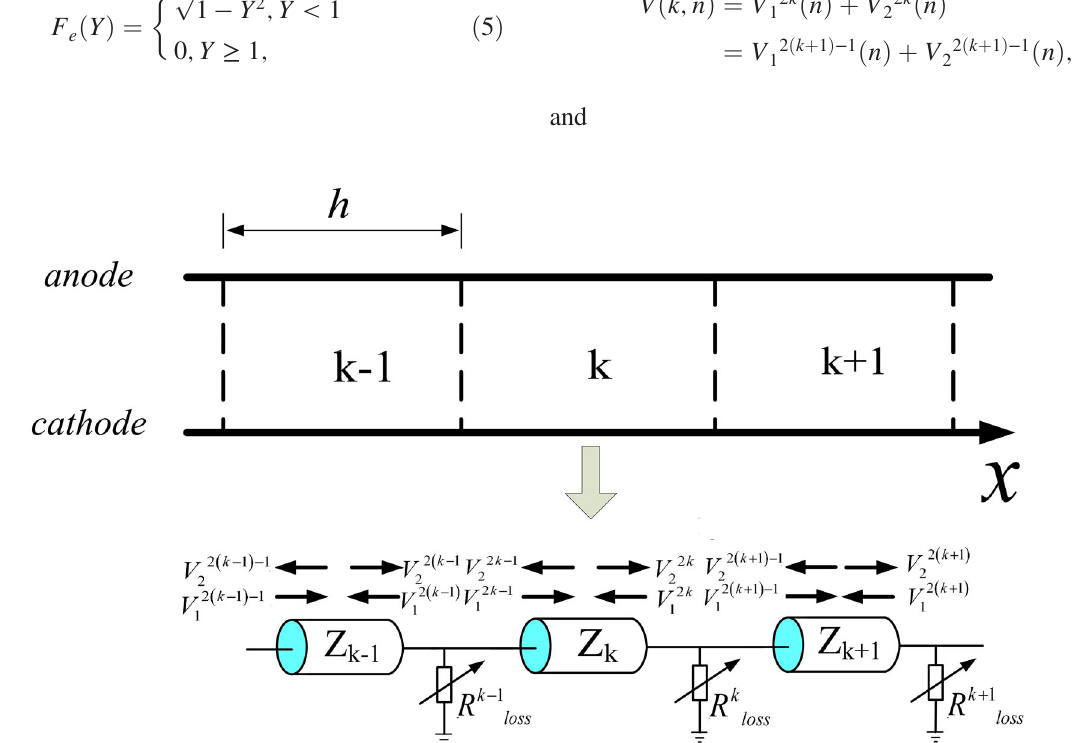
FIG. 6. Schematic of MITL discretization along the transmission direction and the corresponding TL model in the calculation. The grid size is 3 cm and the equivalent electrical length is 0.1 ns (one time step). Each TL element has four voltage vectors, each end with two. A shunt resistor is defined to account for loss current for each TL element and can be updated at every time